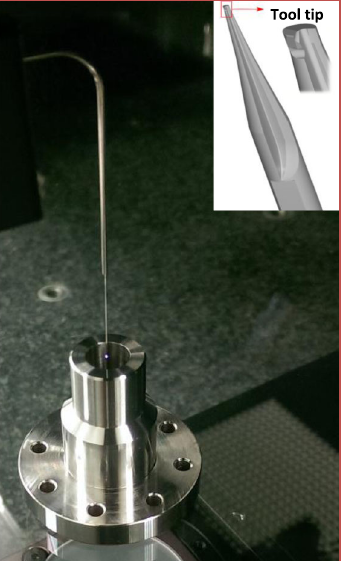
FIG. 4. Nozzle 4 installed in a high-end precision coordinate measuring machine Werth VideoCheck HA in a combination with a fiber probe for measurement of the nozzle inner contour (see Sec. V). A design geometry of a custom-fabricated internal turning tool is shown in the inset.